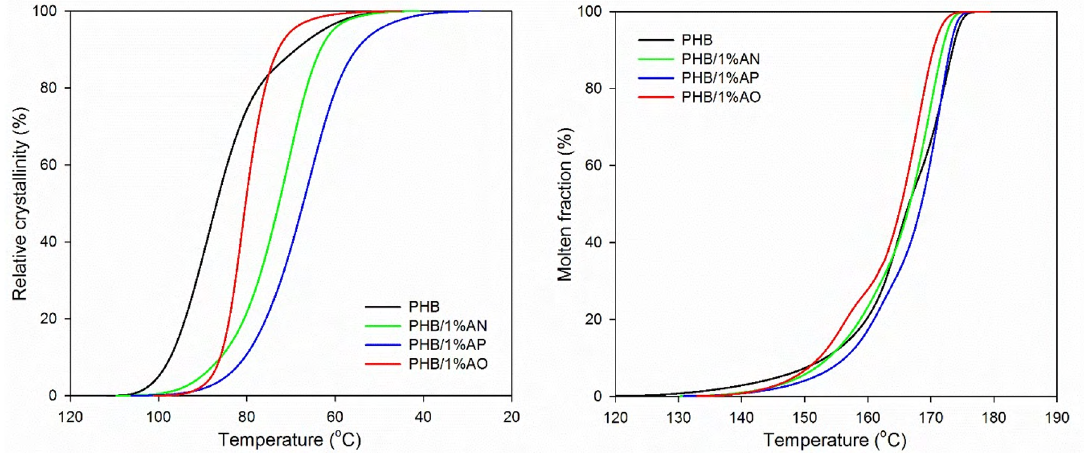
Figure 5. Relative crystallinity (left) and molten fraction (right) as a function of temperature for PHB and PHB/Bentonite compounds.